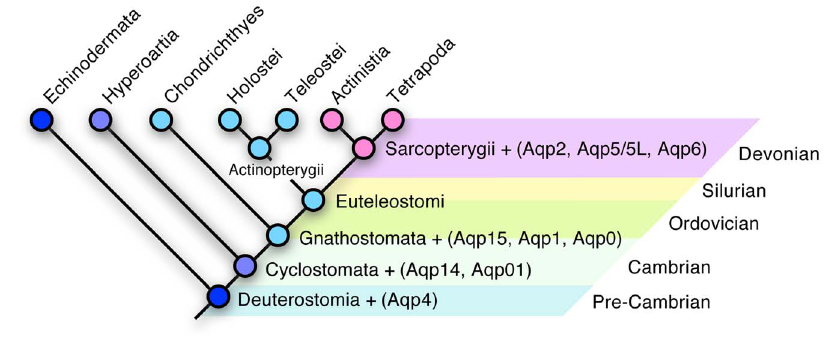
Figure 5. Evolution of the Aquaporin Apormorphy in Sarcopterygii. Schematic illustration showing aquaporin subfamilies identified in deuterstome phyla in relation to geological